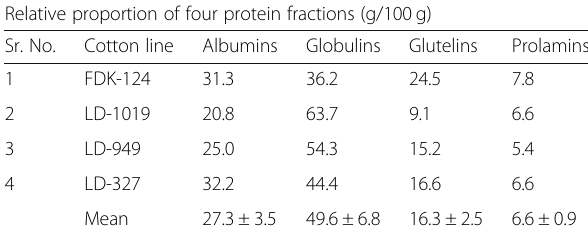
Table 2 Relative proportion of four protein fractions in seeds of cotton lines of G. arboreum